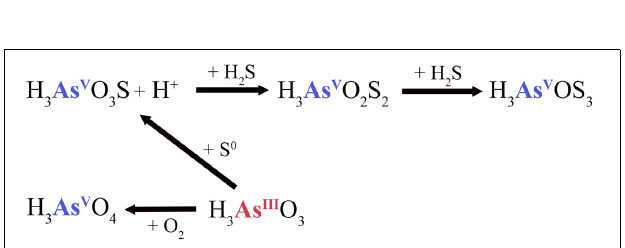
FIGURE 5 | Sulfide-dependent arsenic cycle at the pool (CPp) of Champagne Pool. H 3 AsO 3 S, monothioarsenate; H 3 AsO 2 S 2 , dithioarsenate; H 3 AsOS 3 , trithioarsenate.